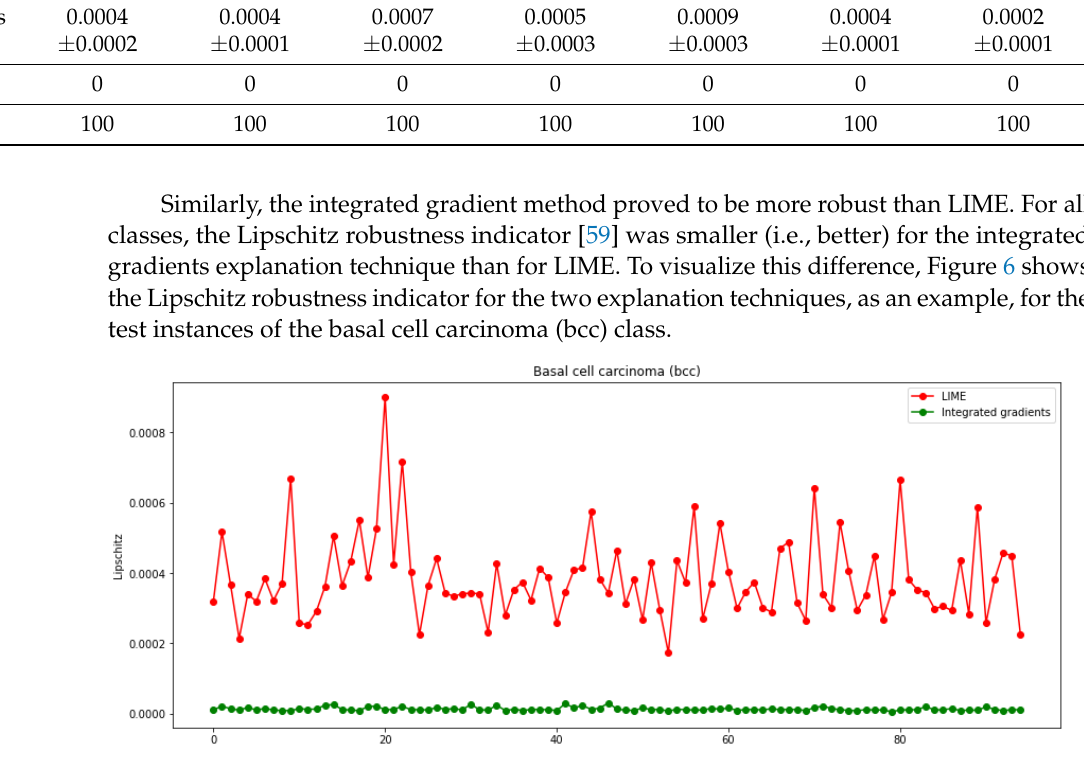
Figure 6. Lipschitz robustness estimate for LIME and integrated gradient explanations for test instances of the basal cell carcinoma (bcc) class. The explanations of the integrated gradient technique are clearly robuster than the LIME